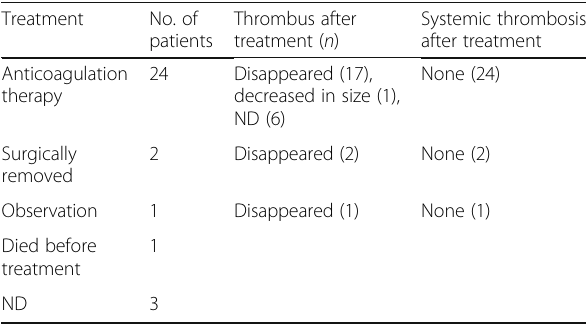
Table 2 Treatment for thrombus in the pulmonary vein stump and outcomes of reported cases